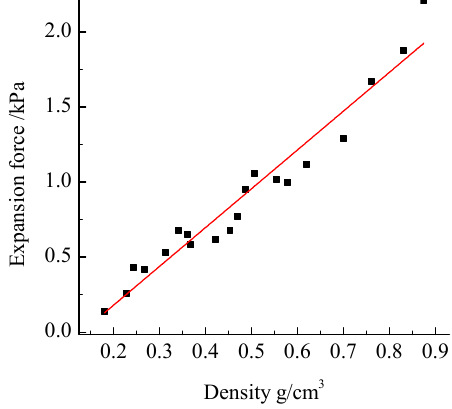
Figure 4. Variation of expansion force and polymer density.